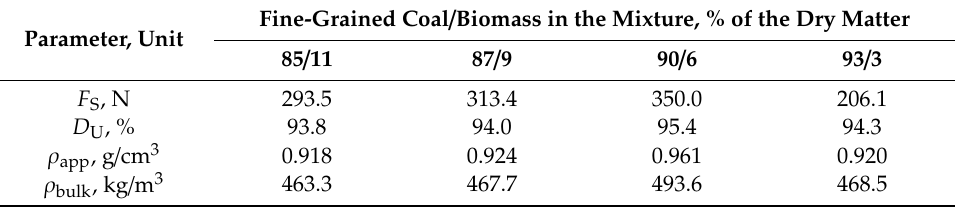
Table 5. Properties of briquettes produced (variable: Coal and biomass raw material proportion). Parameter,